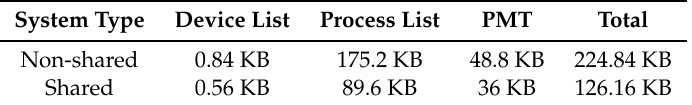
Table 3. Size of Information Records.